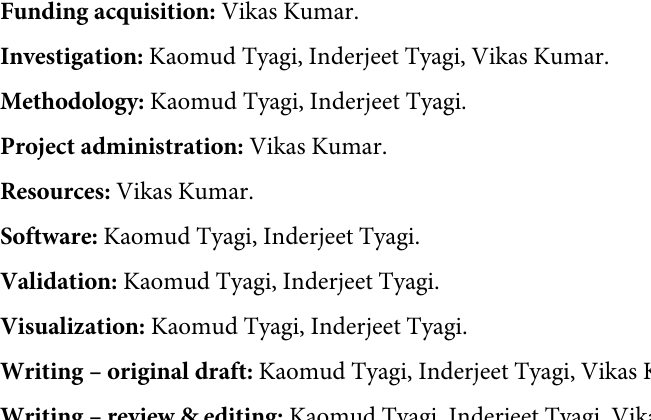
S7 Fig. Representation of the predicted functional metabolic pathway between Lycosidae and Salticidae. S8 Fig. Representation of the predicted functional metabolic pathway between Salticidae and Tetragnathidae. S1 Table. The abundance of the endosymbiont genera of the order Rickettisiales in spider species. S2 Table. Diversity metrics across spider